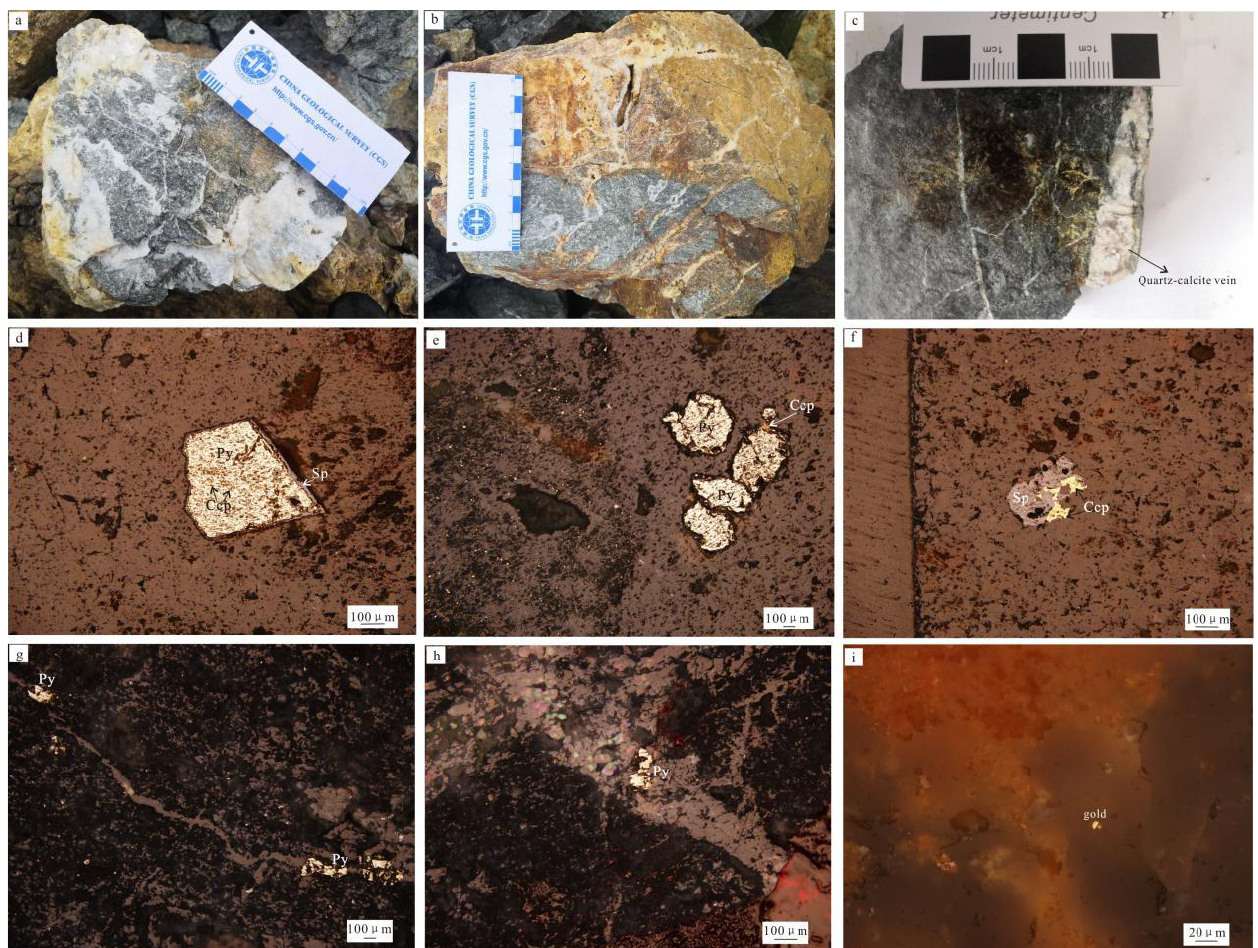
Figure 4. Photographs and microphotographs of the Dongpuzi gold ores. ( a ): The quartz–pyrite- vein-type ore. ( b ): The gold ores characterized by a miarolitic structure. ( c ): The quartz–calcite vein cut through the altered trachyte porphyry. ( d , e ): The subhedral pyrite was metasomatized by later chalcopyrite and sphalerite. ( f ): The sphalerite was metasomatized by later chalcopyrite. ( g , h ): The anhedral pyrite within the quartz veinlet. ( i ): The gold mineral within the quartz veins. Abbreviations: Ccp = chalcopyrite, Py = pyrite, Qz = quartz, and Sp = sphalerite.